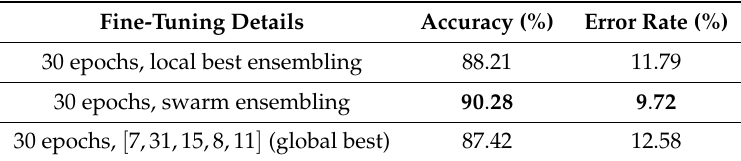
Table 2. Performance measures on the CIFAR-10 test set for 30 fine-tuning epochs following optimisation while using the BLSK-NS weight inheritance method. With the best results highlighted in